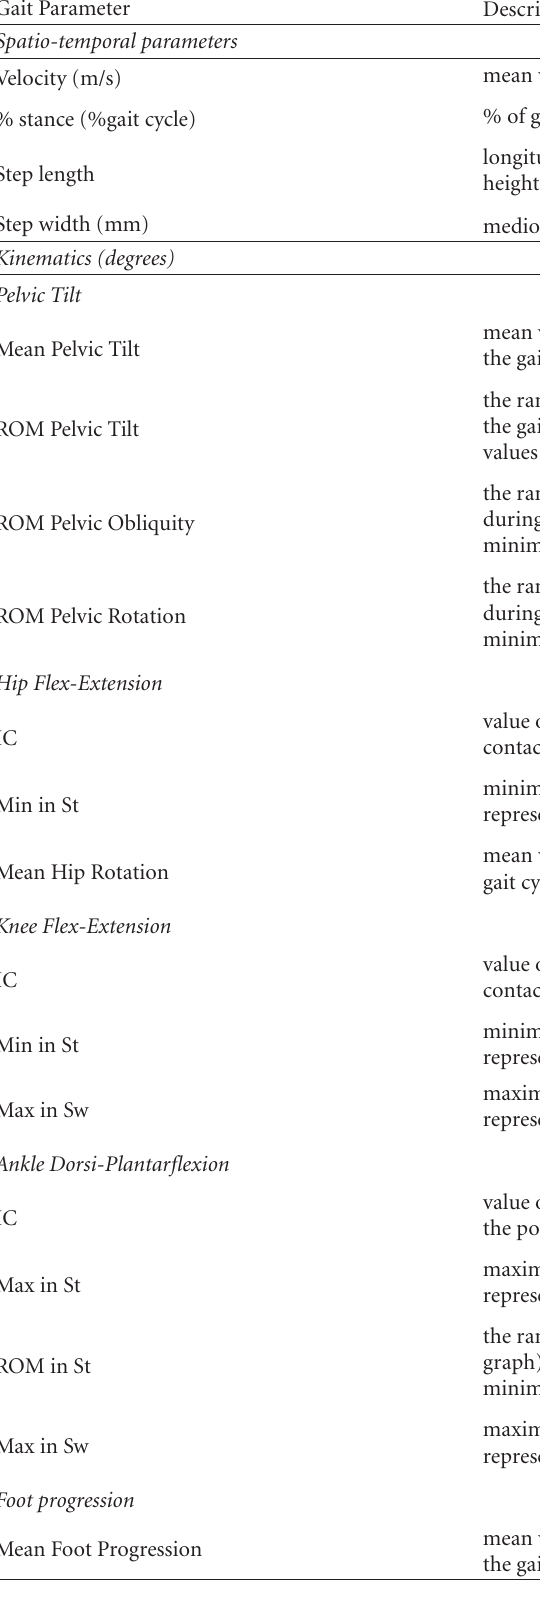
Table 1: Gait parameters and